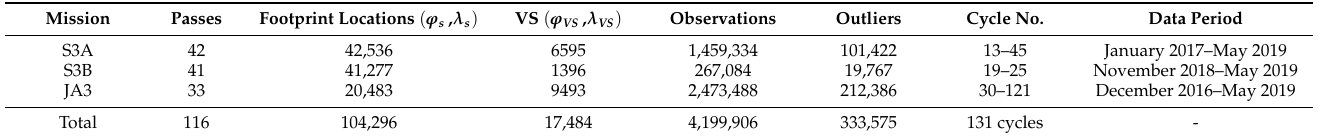
Table 3. SA data details including total number of passes, observations, and outliers for the study area within